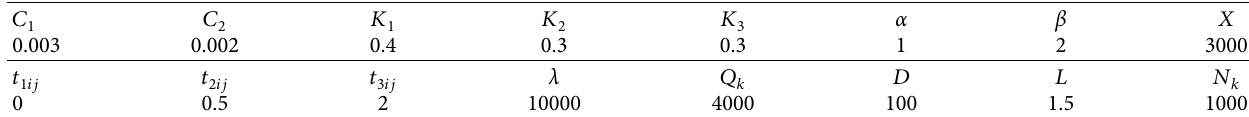
Table 2: Parameters involved in the model.